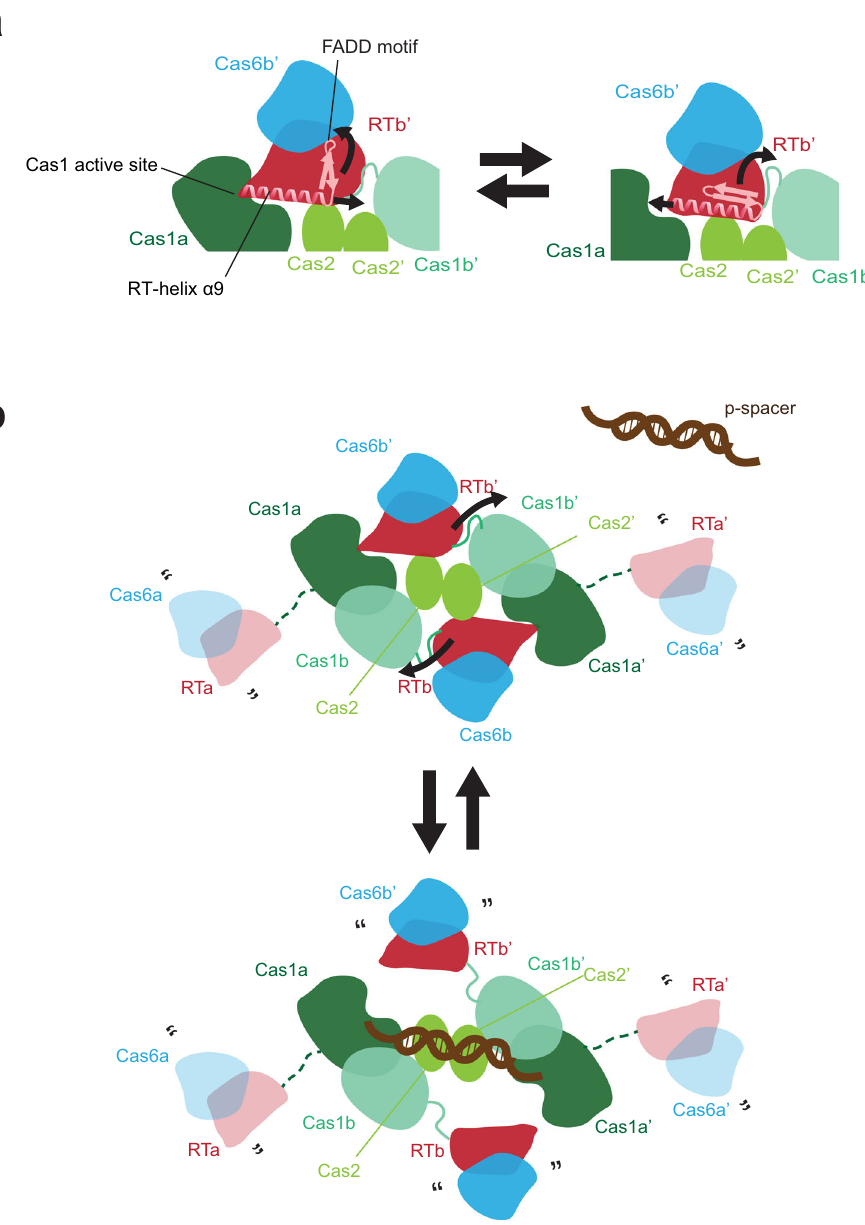
Fig. 7 Model for RT activation. a Cartoon showing hypothesized motion of RT-helix α 9 in and out of the Cas1a active site and the hypothesized motion of the β -strands attached to the FADD motif containing the active site residues. Proteins colored by domain: Cas6, blue; RT, red, Cas1a, dark green; Cas1b, turquoise; Cas2, lime green. Visible RT-Cas1 linkers are shown as solid turquoise lines. RT-helix α 9 and connecting β -strands containing FADD motif are schematized and shown in pink. Hypothesized motions are indicated by curved arrows. b Cartoon showing hypothesized conformational change of the Cas6-RT-Cas1 — Cas2 complex to accommodate a protospacer substrate, with color-coding from a . Missing Cas6-RT domains (Cas6a/RTa and Cas6a ’ / RTa ’ ) that are present in the complex but not visible are depicted as semi-transparent, connected to the rest of the structure by dashed dark green lines. Quotation marks indicate presumed mobility. Protospacer substrate is schematized in brown. Hypothesized motions are indicated by curved